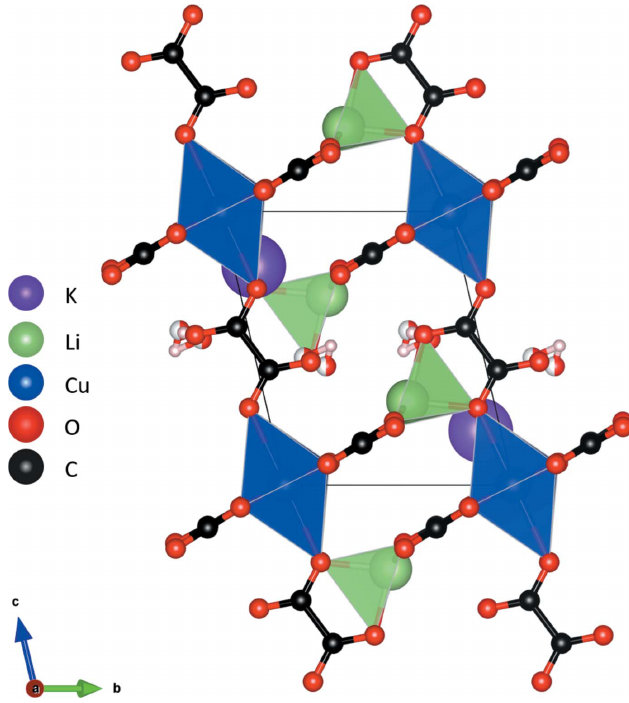
Figure 6 The crystal structure of K 2 Li 2 Cu(C 2 O 4 ) 3 (cid:2) 2H 2 O (III) viewed along the a